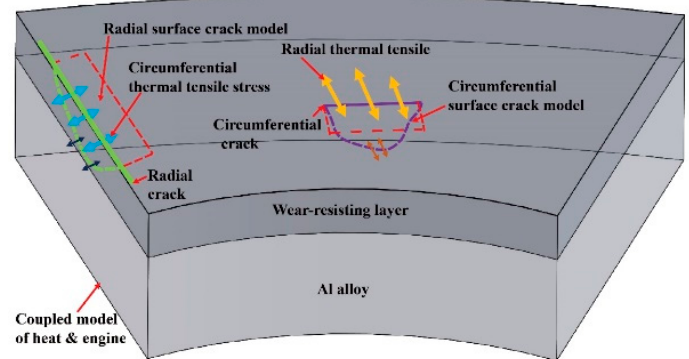
Figure 21. Diagrammatic sketch of thermal tension stress on circumferential and radial cracks.